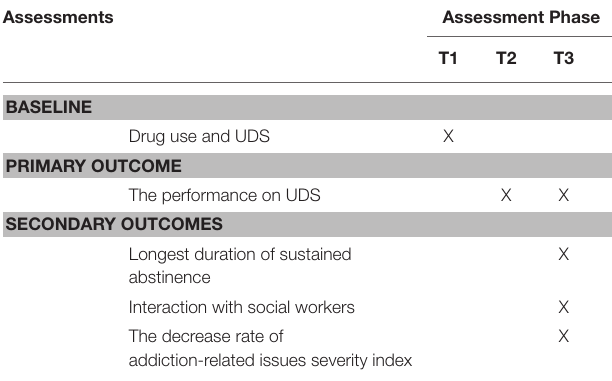
TABLE 3 | Assessments completed at assessment